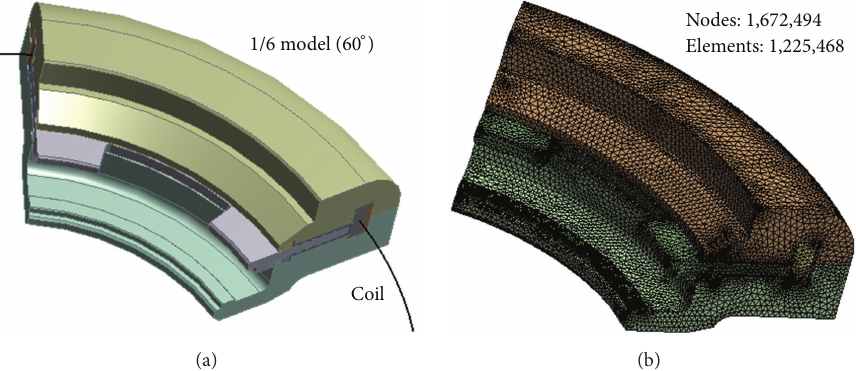
Figure 3: 3D model of the rotary MR damper for FE analysis. (a) One-sixth MR damper model. (b) Finite element (FE) model.